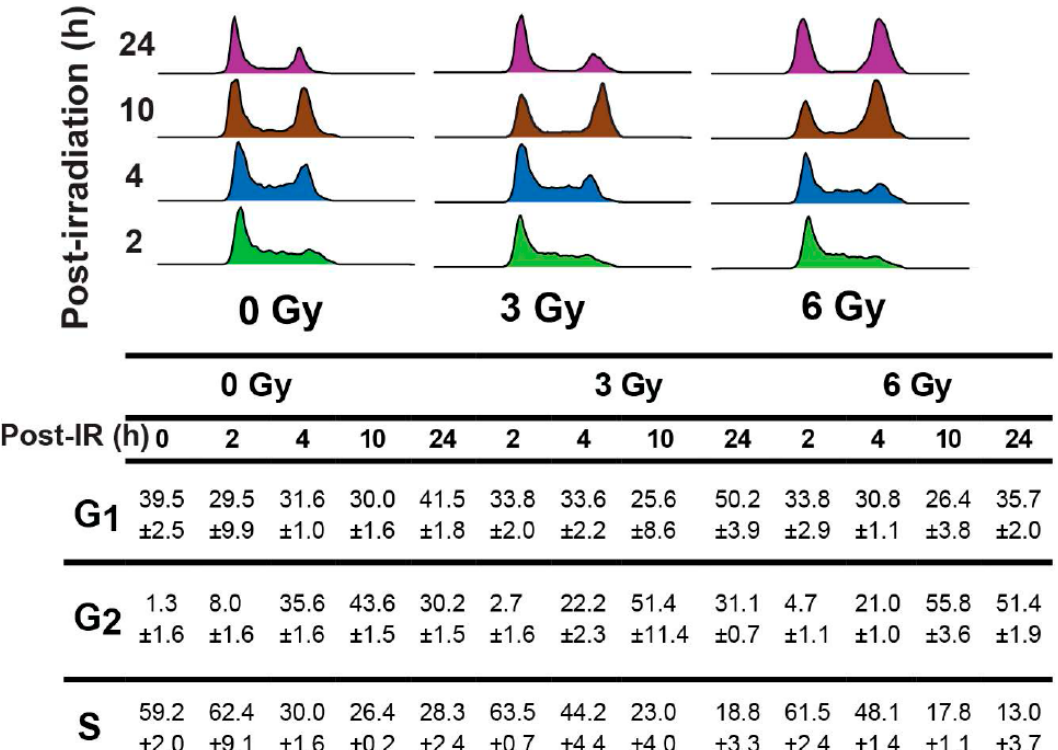
Figure 5. Cyclin B1 mitochondrial and nuclear translocations were associated with the delay and restart of the cell cycle. Confluent NHFs were re-plated and irradiated with 3 and 6 Gy at 18 h post-replating. Control and irradiated cells were harvested at indicated times for flow cytometry analysis of cell cycle phase distributions. A representative propidium iodide (PI)-histogram of DNA content is shown on the top panels. The percentage of cell cycle phases was calculated using the FlowJo software (FlowJo LLC, Ashland, OR, USA) and is expressed as mean ± standard deviation.